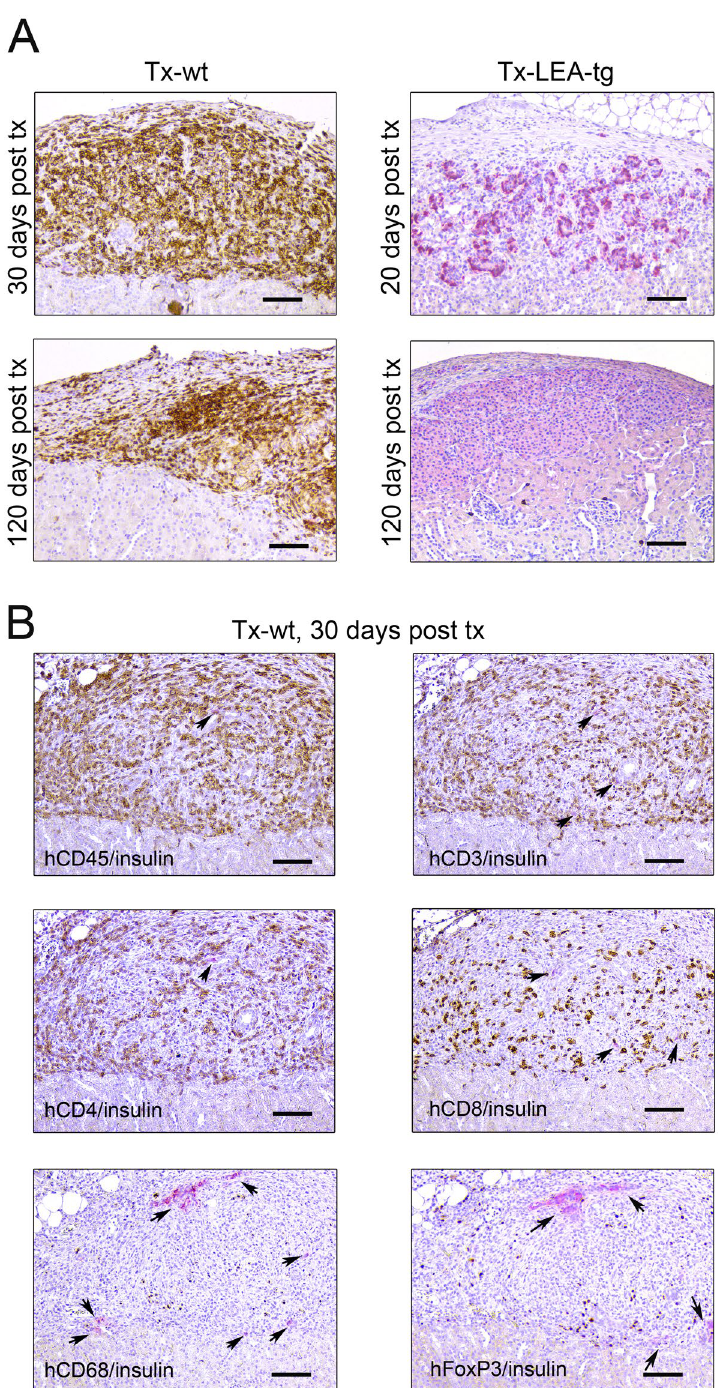
Figure 3. Histological analysis of transplanted NPICCs. Islet xenografts were investigated at day 30 and day 120 post Tx. ( A ) Staining for insulin (red) revealed that wild-type NPICCs were rejected and displayed a strong infiltration with human CD45 + (brown) immune cells. LEA29Y expressing islets were protected from rejection and exhibited a preserved islet xenograft with few infiltrating CD45 + cells. ( B ) Transplanted wild-type NPICCs at day 20–30 post Tx stained against insulin (red) and human CD45, CD3, CD4, CD8, CD68, and FoxP3 (brown): only few insulin + cells (arrows) are detectable but massive immune cell accumulation whereby infiltrating cells mostly consist of hCD4 + and hCD8 + lymphocytes, some macrophages, and few FoxP3 + T cells. Scale bar: 100 μ